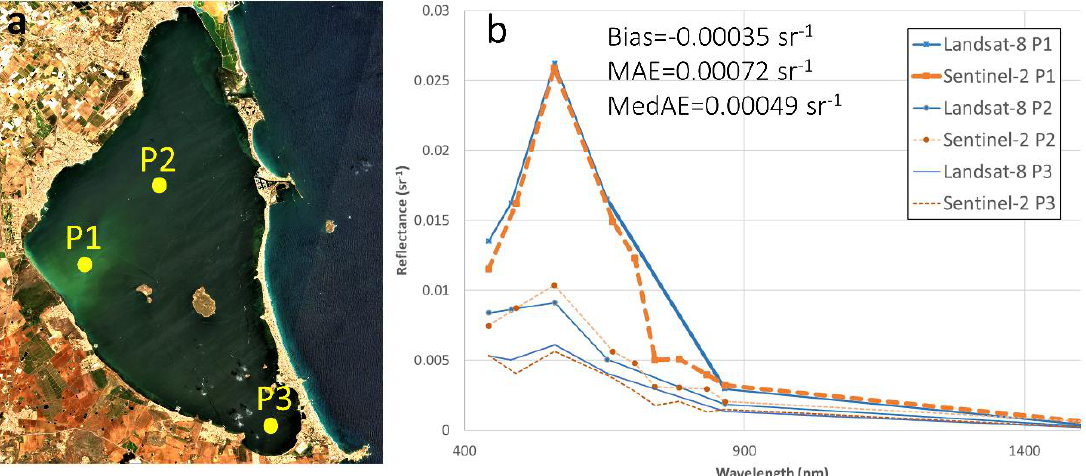
Figure 7. ( a ) RGB (Red – Green – Blue) composite image on 3 August 2021 of the Sentinel-2 satellite at bottom-of-atmosphere (BOA) level, ( b ) spectral signal of the Sentinel-2 and Landsat-8 satellites over different control points (P1, turbidity of 18.11 and 17.28 FNU; P2, turbidity of 5.5 and 6.1 FNU; and P3, turbidity of 4.08 and 3.93 FNU for Sentinel-2 and Landsat-8, respectively). Yellow circles in ( a ) indicate the location of the control pixels.